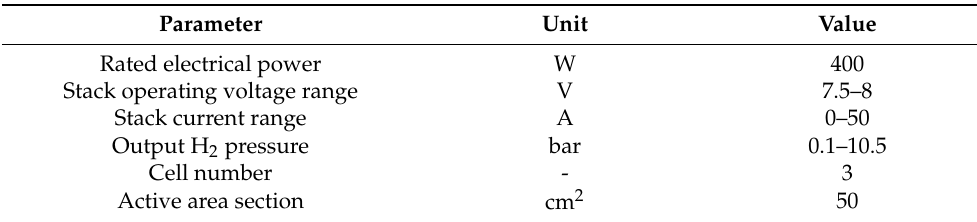
Table 1. Main characteristic of PEM electrolytic stack experimentally tested by Guilbert and Vitale in